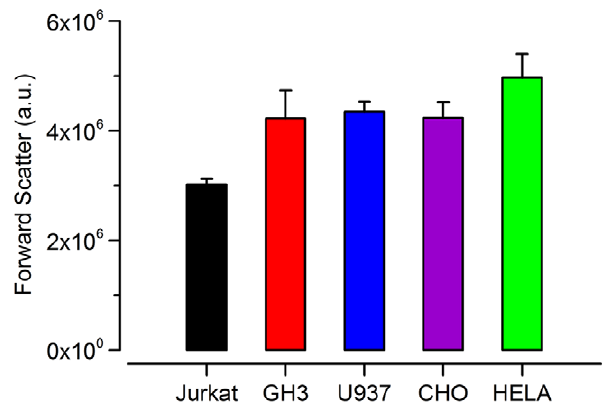
Figure 7. Comparison of ED 50 for PS externalization and propidium uptake with LD 50 in different cell lines. Error bars represent the 95% confidence intervals, as calculated from best fit using logarithmic function (see Fig. 2 and 6).